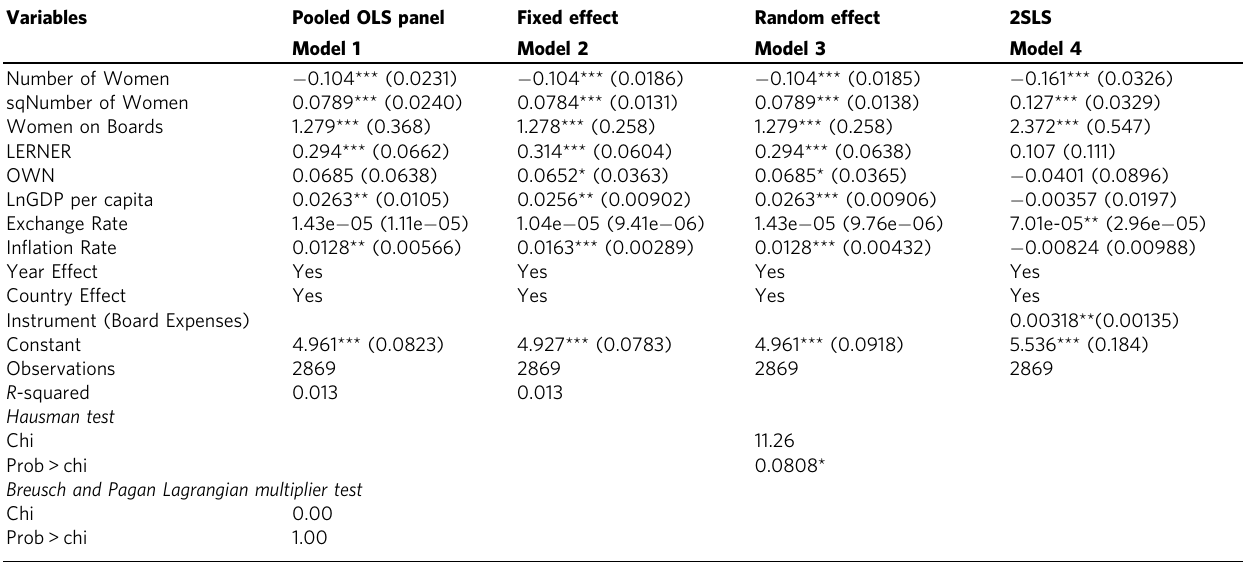
Table 4 The relationship between board gender diversity and bank